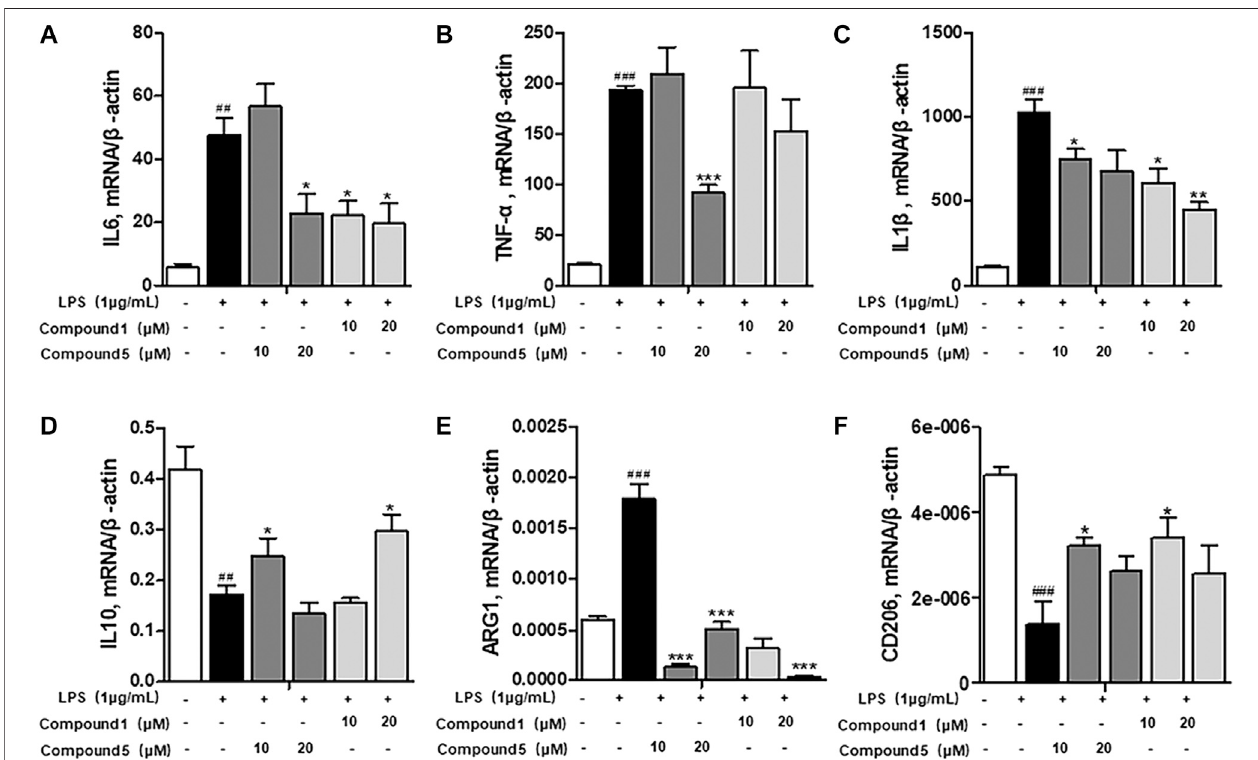
FIGURE 8 | In fl uences of 1 and 5 on the transcription level of macrophage markers. The expression of in fl ammatory markers IL6 (A) , TNF- α (B) , and IL1 β (C) and immunomodulatory markers IL10 (D) , ARG1 (E) , and CD206 (F) in 1- or 5 -administrated RAW264.7 cells activated by LPS. Data were presented as the mean ± SEM ( n (cid:2) 3). ## p < 0.01, ### p < 0.001 vs. control, * p < 0.05, ** p < 0.01, *** p < 0.001 vs.